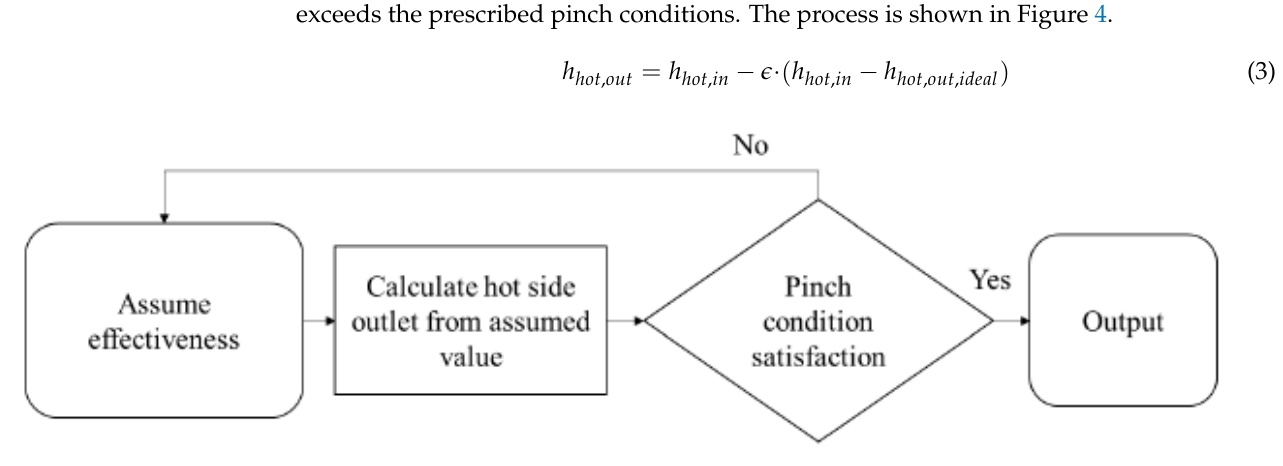
Figure 4. Effectiveness model algorithm.